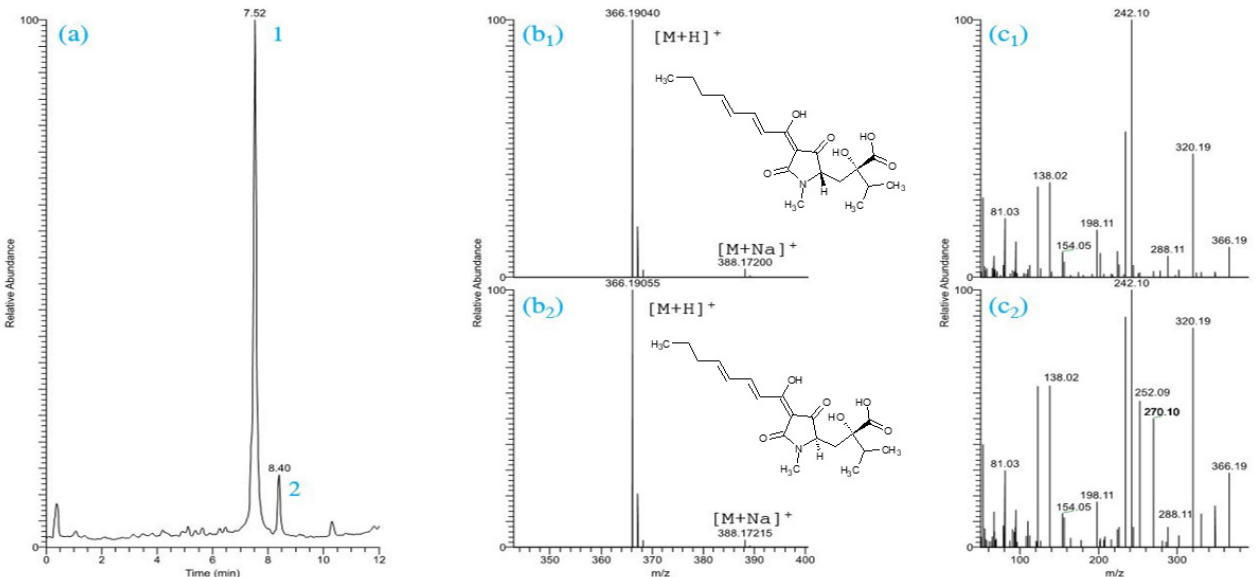
Figure 1. ESI(+)LC/MS total-ion current (TIC) trace of fraction F416, where 1 and 2 are peak No. ( a ), ESI(+)LC/MS mass spectra and chemical structures of harzianic acid ( b 1 ) and iso-harzianic acid ( b 2 ), ESI(+)LC/MS/MS product-ion mass spectra of HA ( c 1 ), and iso-HA ( c 2 ).